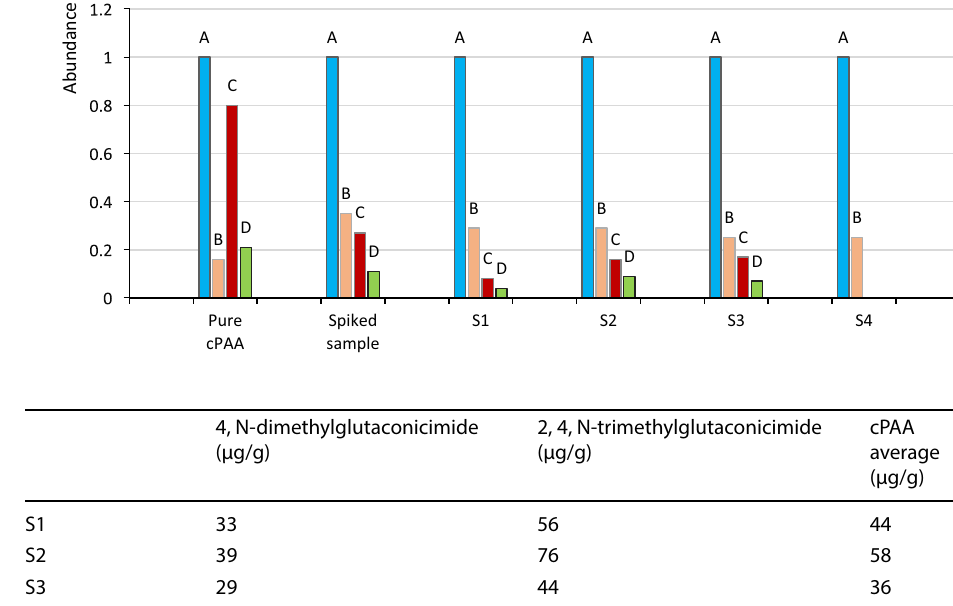
4, N-dimethylglutaconicimide